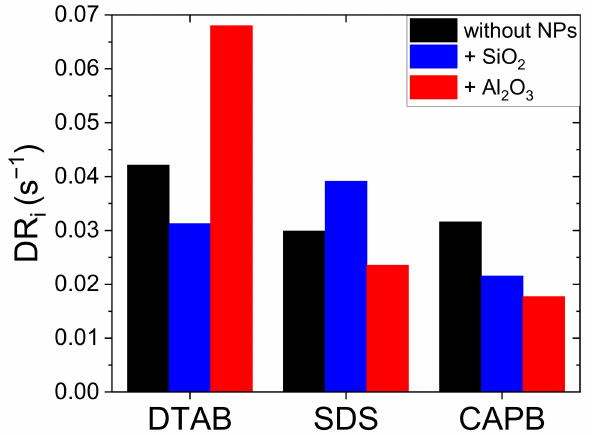
Figure 7. Initial drainage rate ( DR i ) of CO 2 foams formed for DTAB, SDS, and CAPB, in the absence and presence of 1.0 wt % SiO 2 or Al 2 O 3 (in desulphated seawater brine, at 25 ◦